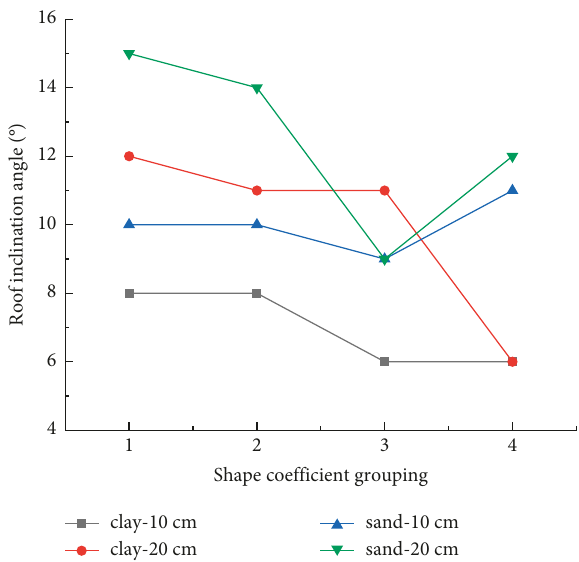
Figure 13: A representative value of tension in the pull-out test.